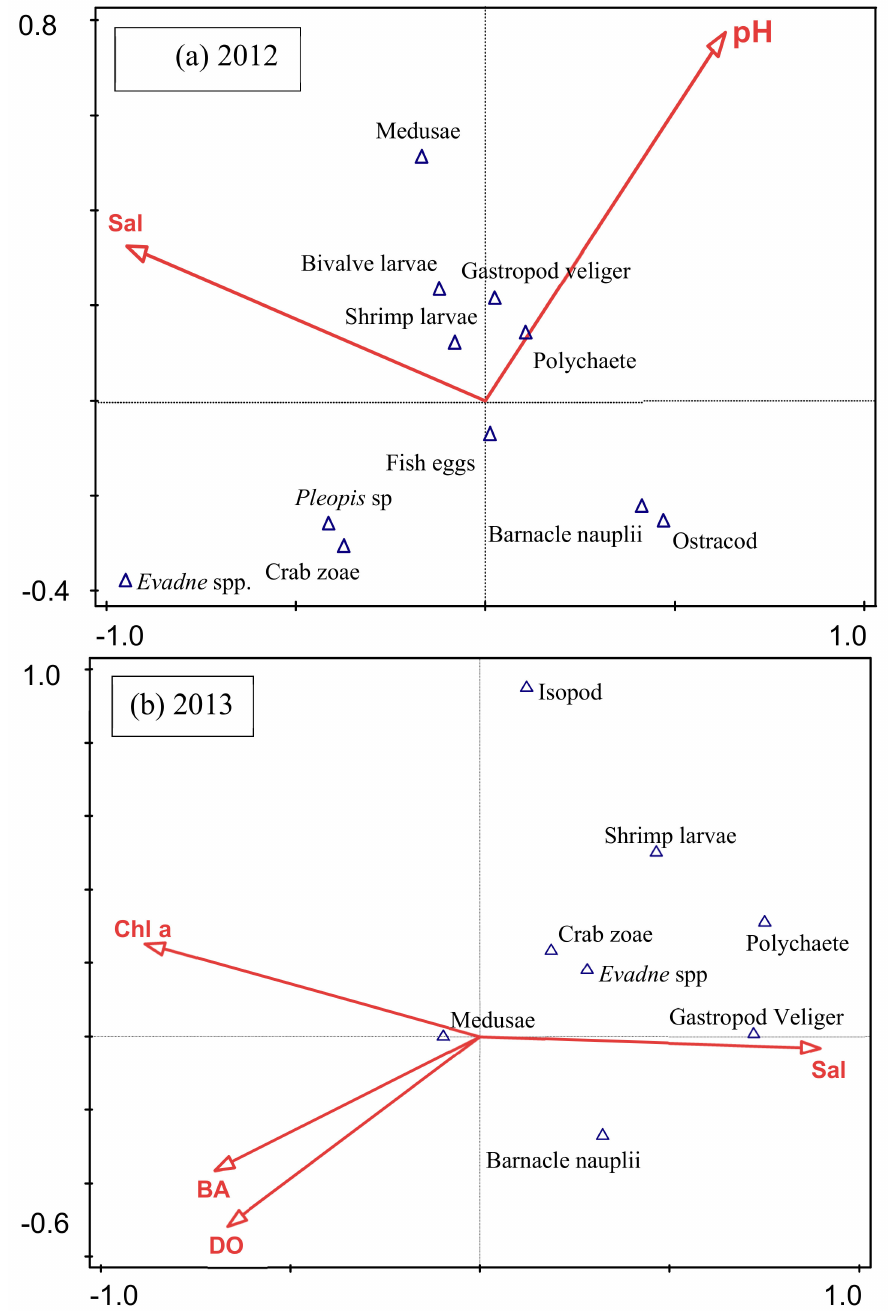
Figure 9. Results of CCA analysis showing environmental variables and taxa relationships in: 2012 ( a ); and 2013 ( b ) in MCBs. BA, bay anchovy; DO, Dissolved oxygen; Sal, Salinity; Chl a , Chlorophyll